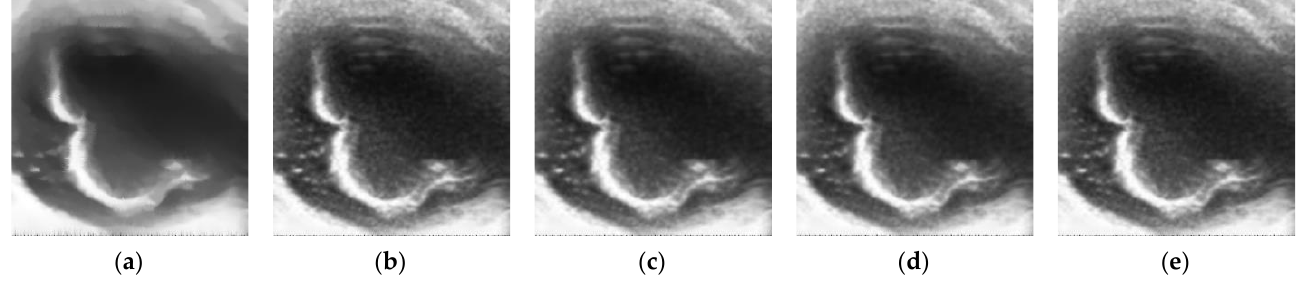
Figure 6. Results of vitreous mechanization image processing by different orders of α denoising model. ( a ) α = 1. ( b ) α = 0.4. ( c ) α = 0.8. ( d ) α = 1.2. ( e ) α = Table 1. Evaluation index of the image after denoising of different orders .